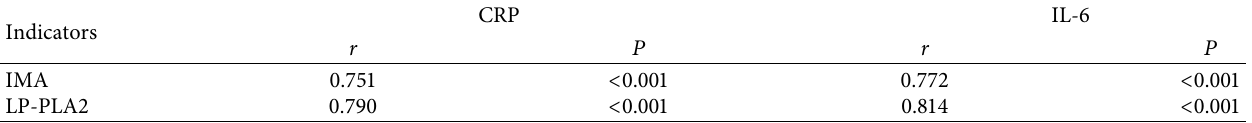
Table 4: Correlation of serum IMA, LP-PLA2 levels with serum CRP, IL-6 levels in patients with CHD. Indicators